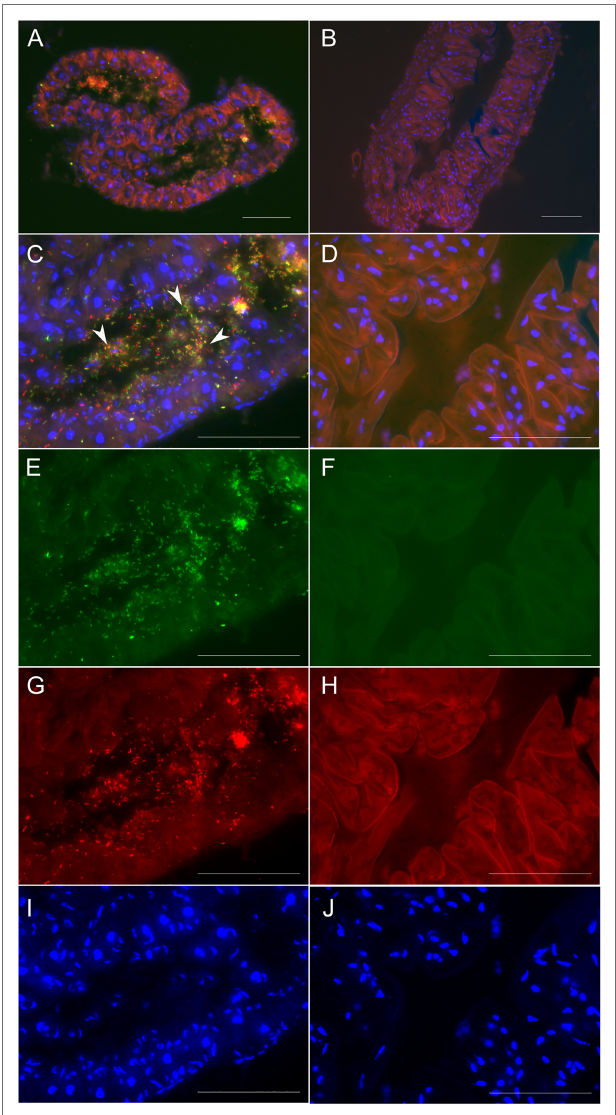
FIGURE 5 | Micrographs showing environmental acquisition of B. gladioli Lv-StA by L. villosa or absence in an unexposed control. (A,C,E,G,I) Lv-StA presence in cross-sections (8 μ m) of the accessory glands of an adult L. villosa that had been exposed to Lv-StA during the larval stage. (B,D,F,H,J) show an aposymbiotic control individual. In (A) and (C) , symbiont cells are represented in yellow and white arrowheads denote exemplary symbiont cells. Fluorescent signals in individual channels correspond to (E,F) Burkholderia specific labeling in green (Burk_16S-Cy5), (G,H) general eubacteria labelled in red (EUB338-Cy3), and (A–D,I,J) nucleic acids unspecifically labeled in blue (DAPI) showing host cell nuclei. The scale bars represent 50 μ m. For clarity, H shows autofluorescence from the host tissues in the Cy3